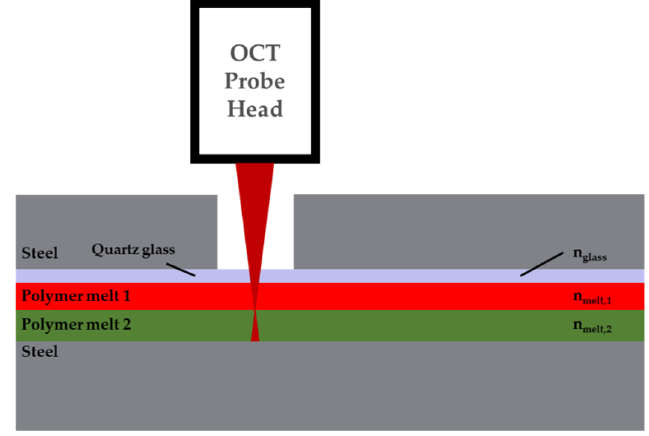
Figure 5. OCT measurement arrangement of OCT for the detection of flow instabilities.